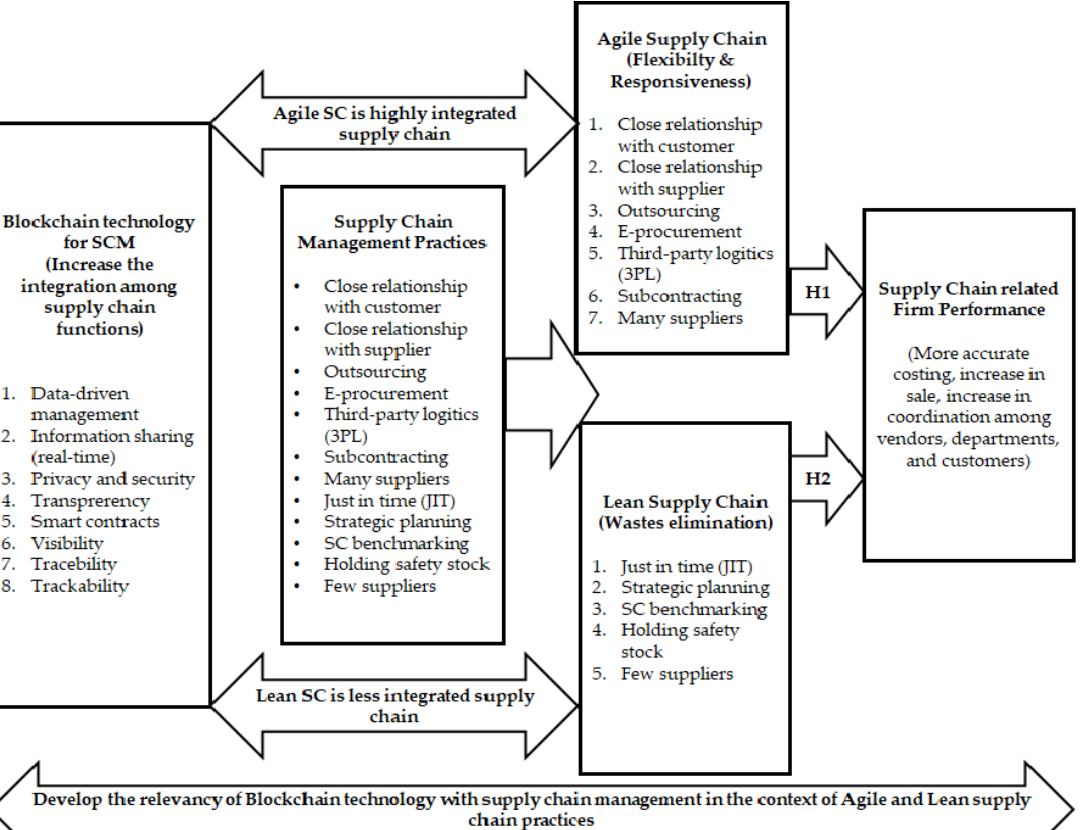
Figure 2. Proposed framework.